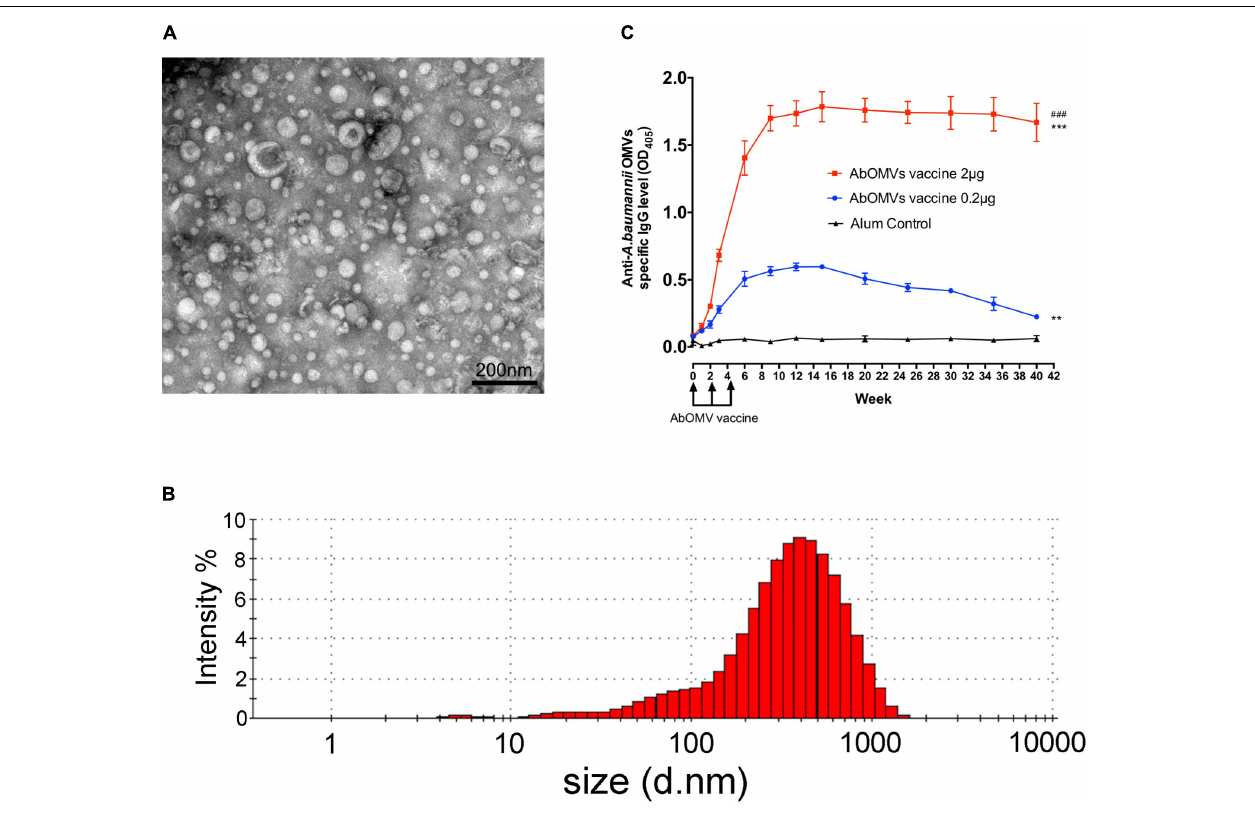
FIGURE 1 | Generation of AbOMVs and mouse immunization. (A) OMVs secreted by the Ab112 strain were observed under a transmission electron microscope in a random field of view, bar: 200 nm. (B) The OMV diameters were analyzed using a particle size analyzer. (C) ELISA was performed to measure the specific anti-AbOMV IgG antibody levels after mice were immunized with the AbOMVs ( n = 5). # Represents the comparison between the 2 and 0.2 µ g dose groups; ∗ represents the comparison between each group and the Alum control group; ∗∗∗ / ### P < 0.001; ∗∗ P < 0.01.